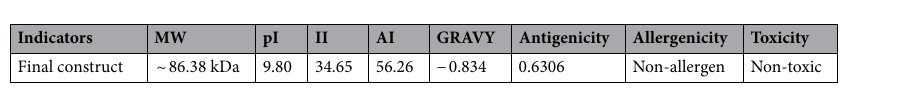
Table 4. Physicochemical and immunological properties of the final